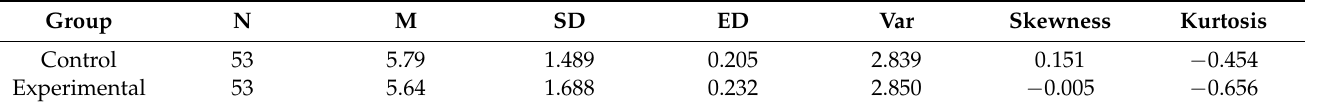
Table 1. Descriptive statistics of pretest data.